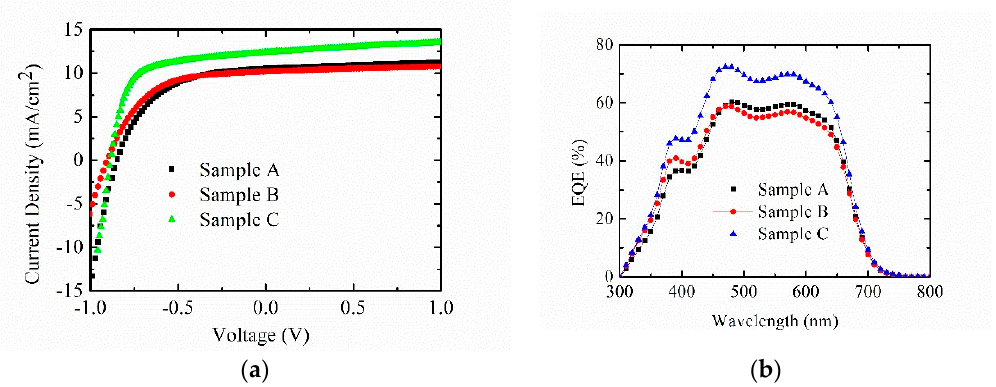
Figure 4. ( a ) The J–V curves of SM-OPVs with various solvents and treatment conditions. ( b ) The EQE spectra of sample A, sample B, and sample C.